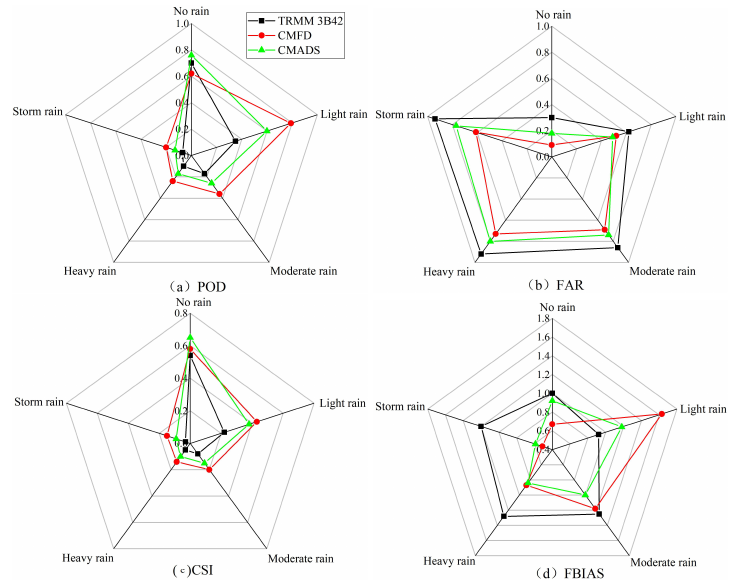
Figure 7. Radar distribution of statistical indicators under different precipitation intensities.